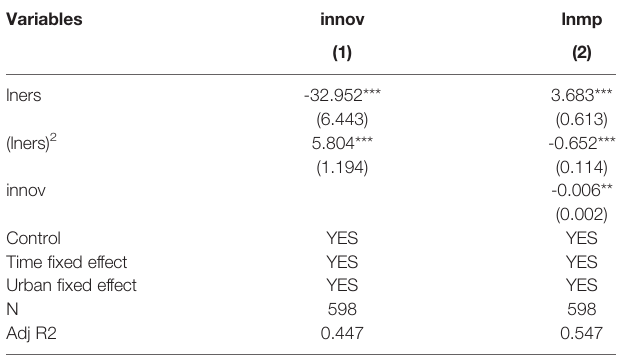
TABLE 5 | Mechanism